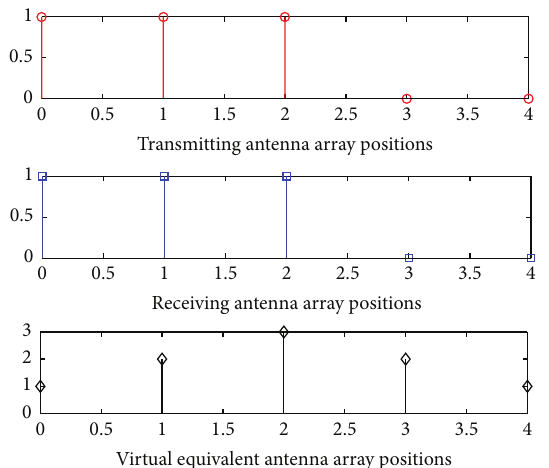
Figure 3: Antenna array designs of NSK polynomial factorization and inverse convolution.